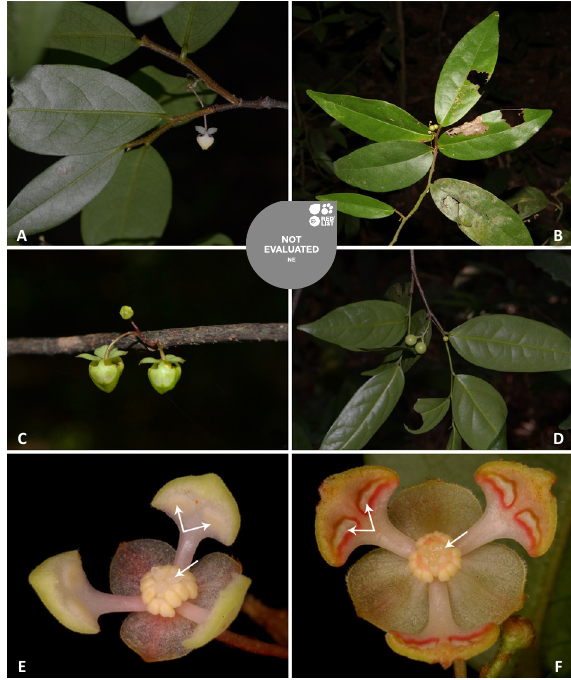
Image 1. Field photographs of live specimens. A & B - Flowering and fruiting twigs of Orophea malabarica Sasidh. & Sivar.; C & D - Flowering and fruiting twigs of Orophea sivarajanii Sasidh.; E - Single flower showing 3-carpellary gynoecium and 2-oblong protruding nectarines on the inner petals of O.malabarica ; F - Single flower showing 6-carpellary gynoecium and 2-pouched nectarines on the inner petals of O.zeylanica . © A–D: R. Arun Singh; E–F: Navendu